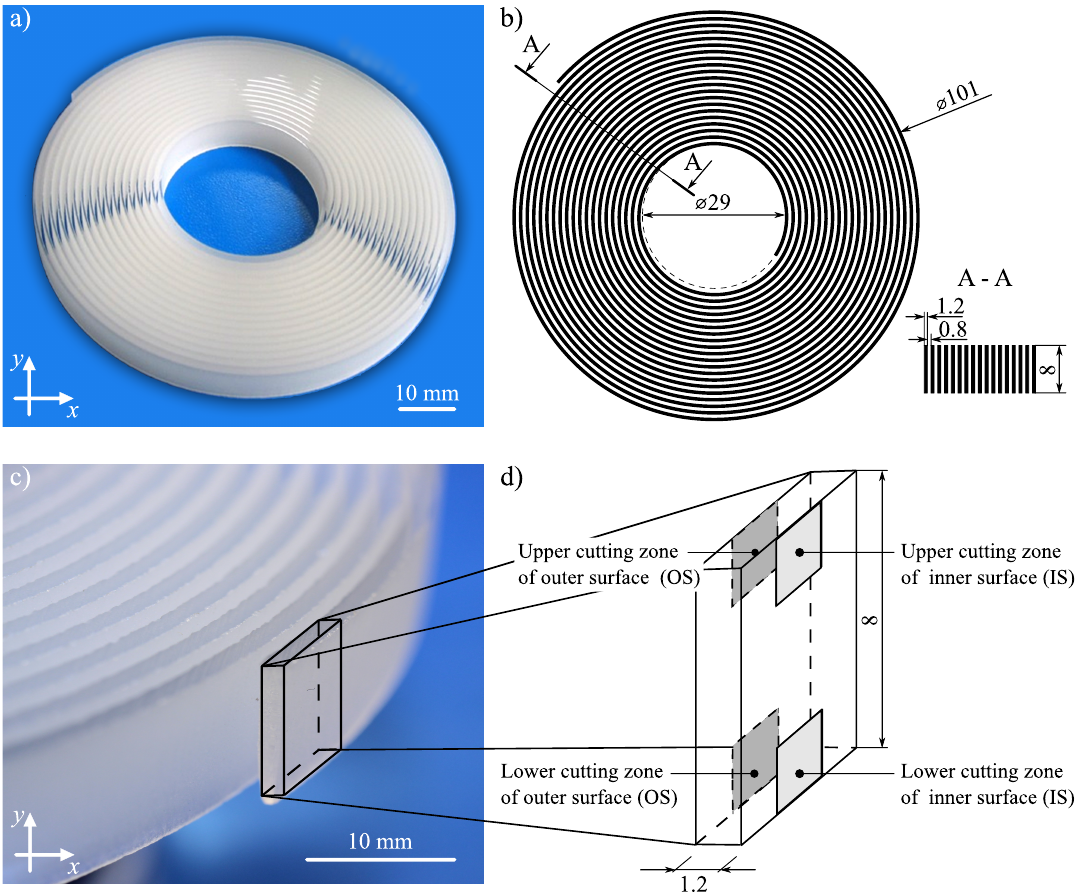
Figure 3. The soda–lime glass spiral used in the experimental studies: ( a ) general view of the spiral; ( b ) basic geometrical dimensions; ( c , d ) a section of the spiral with the upper / lower inner and outer surfaces (IS and OS)